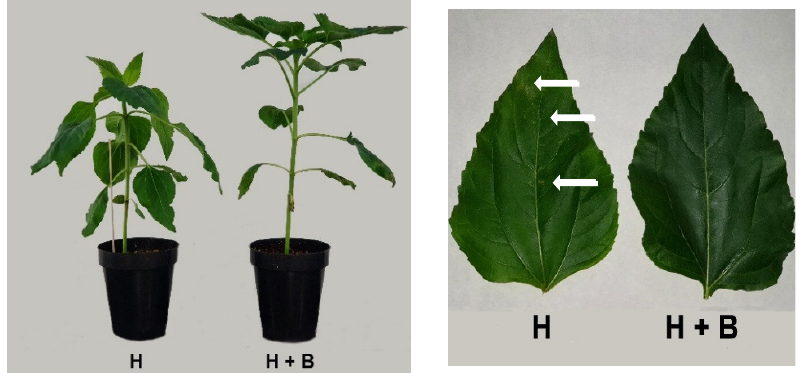
Figure 1. Sunflower plants and leaves 4-days after the application of the treatments (H: Pulsar_40; H + B: Pulsar_40 + Terra-Sorb ® ). Arrows on sunflower leaves indicate chlorotic spots on plants treated with the herbicide (H).